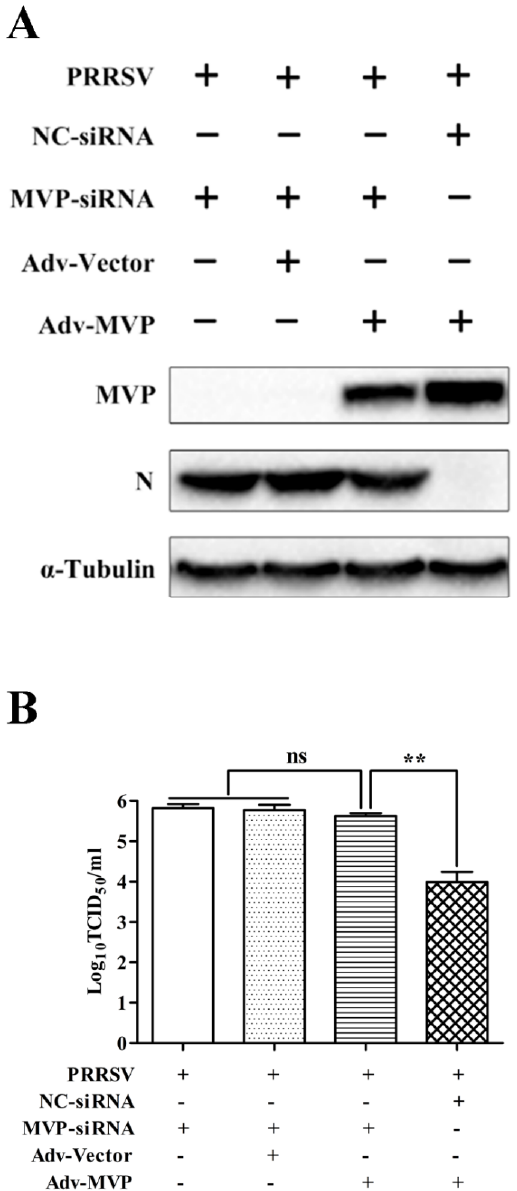
Figure 5. MVP knockdown has a restraining function on the inhibiting effect of MVP overexpression on PRRSV replication. CRL2843 CD163 cells were transfected with NC − siRNA or MVP − siRNA for 12 h followed by infection with Adv − Vector or Adv − MVP (MOI = 5) for 12 h. Then, cells were infected with GD-HD PRRSV (MOI = 1) for 48 h. The expression levels of MVP and the PRRSV N protein were detected by Western blot ( A ). Virus titers in cell supernatants were measured by TCID 50 ( B ). Alpha-tubulin was used as the internal loading control for Western blot analysis. Data from three independent experiments are expressed as the means ± SD. Analysis of differences between the means was performed using Student’s t -tests and ANOVA. Significant differences are marked by ns (no significant), and ** ( p < 0.01)